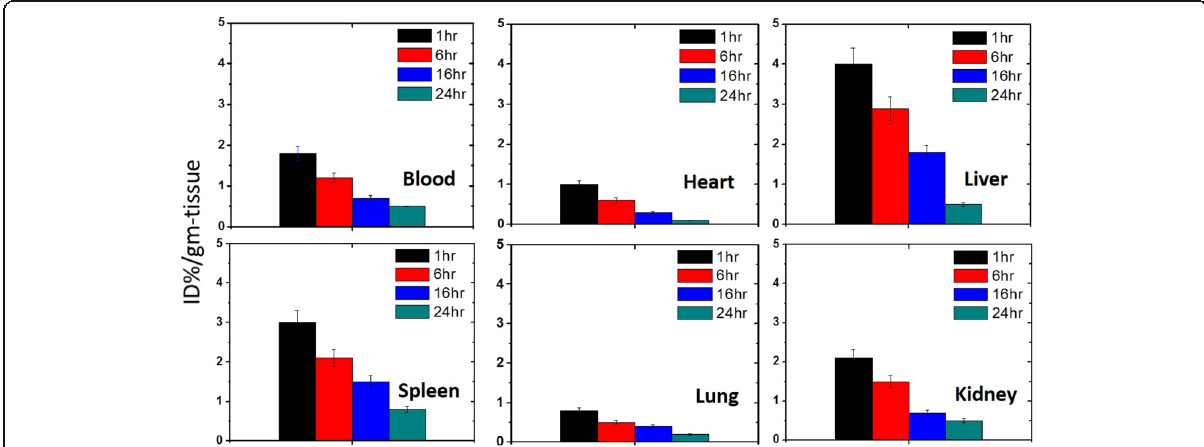
Fig. 7 Biodistribution of PEG-CoFe 2 O 4 nanoparticles in the blood, heart, liver, spleen, lungs, and kidney after different intervals (1, 6, 16, and 24 h) of exposure to mice. The error bars in the obtained data are shown in the figure